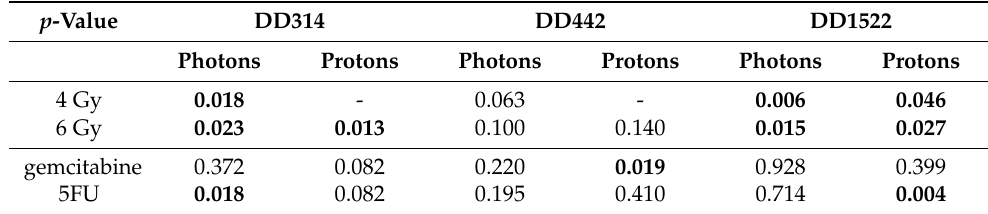
Table 2. Therapeutic effects after treatment with RT and CT on day 13.